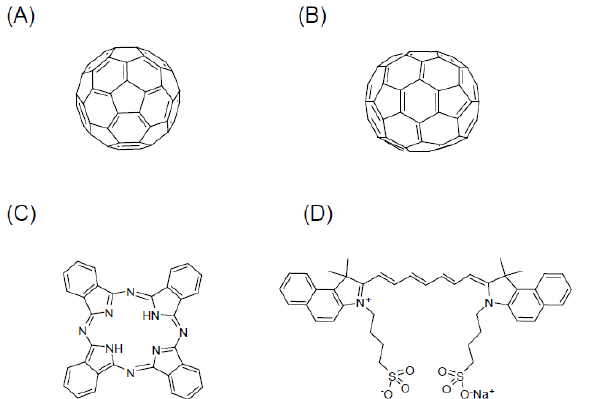
Figure 5. The molecular structure of types of PSs photosensitizers that are expected to be clinically developed in the future due to sugar conjugation. ( A ) Fullerene (C60), ( B ) fullerene (C70), ( C ) phthalocyanine (Pc), and ( D ) indocyanine green (ICG).